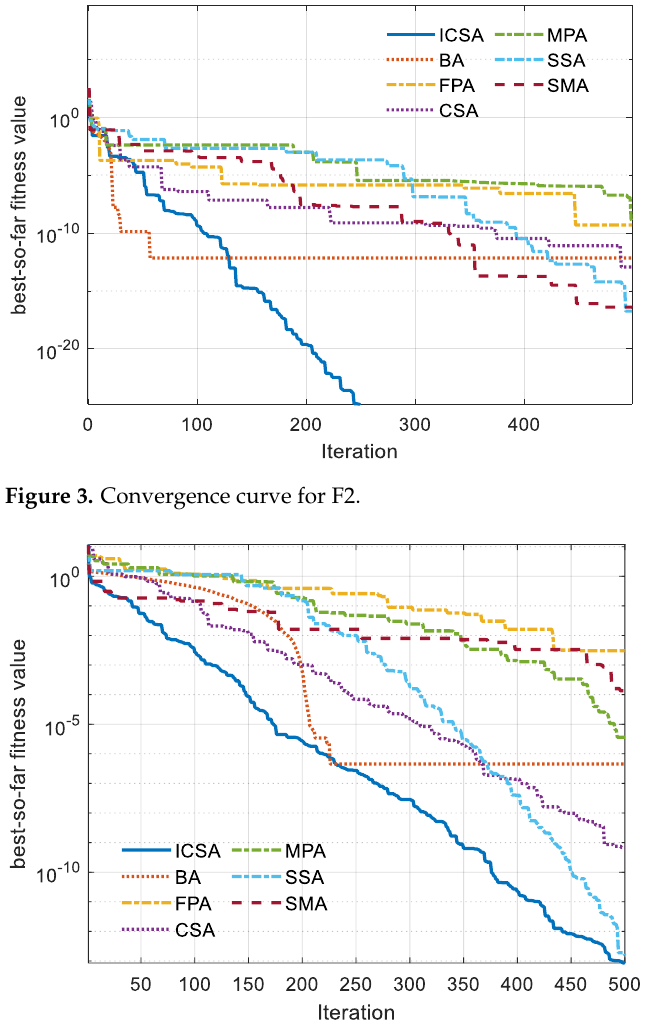
Figure 2. Convergence curve for F1.